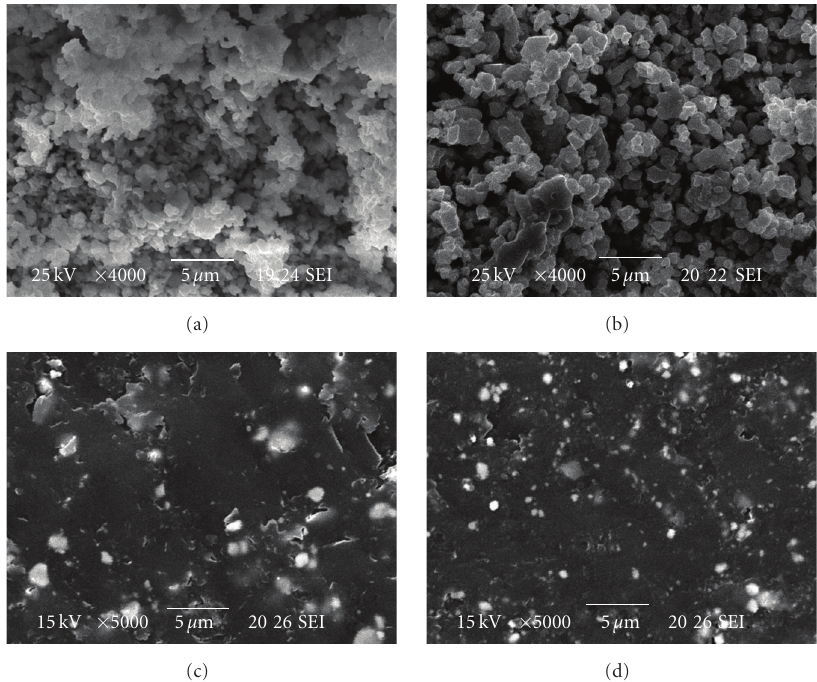
Figure 2: Micrographs of BST ceramic powders ((a) and (b)) and composites ((c) and (d)): (a) x = 0 . 2, (b) x = 0 . 4, (c) BST( x = 0 . 2)-epoxy 10 vol%, and (d) BST( x = 0 . 4)-epoxy 15 vol%.